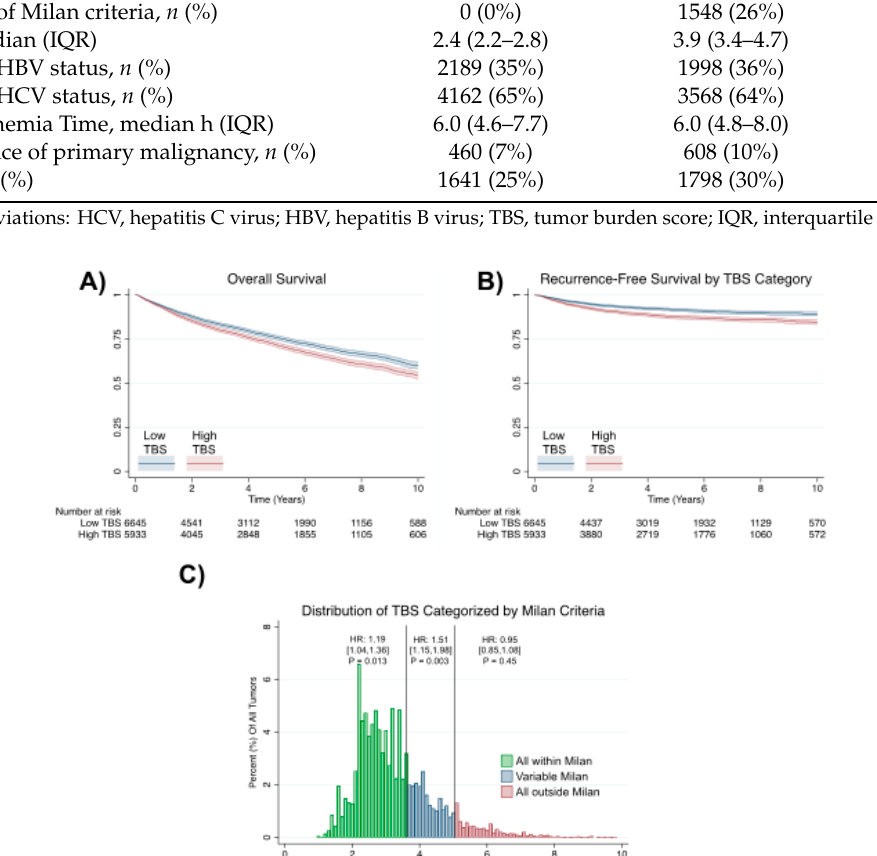
Figure 2. Correlation of the median TBS with ( A ) total transplant volume and ( B ) total hepatocellular carcinoma (HCC) transplant volume.